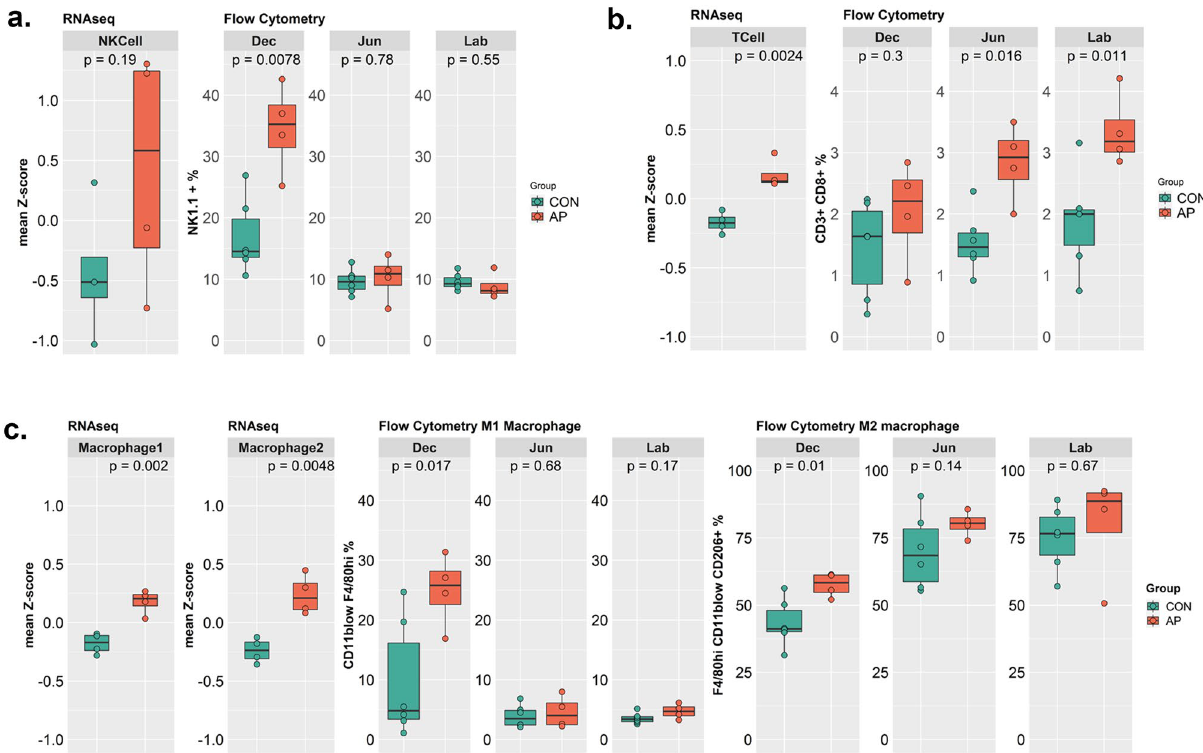
Figure 3. Abundance of various immune cells in different placental compartments: ( a , b ) showing the abundance of NK cells ( a ) and T cells ( b ) in placentas of CON or AP group based on Bulk RNA-seq (left panel; n = 4 sequenced from each group obtained from n = 6 pregnant mice) or Flow cytometry data (right panel; n = 6 from each group) from three different compartments of placentas. ( c ) abundance of total macrophages between CON and AP groups (left panel) as obtained from Bulk RNA-Seq and abundance of M1 and M2 macrophages from three different compartments of mouse placentas by Flow cytometry (right panel). Statistical